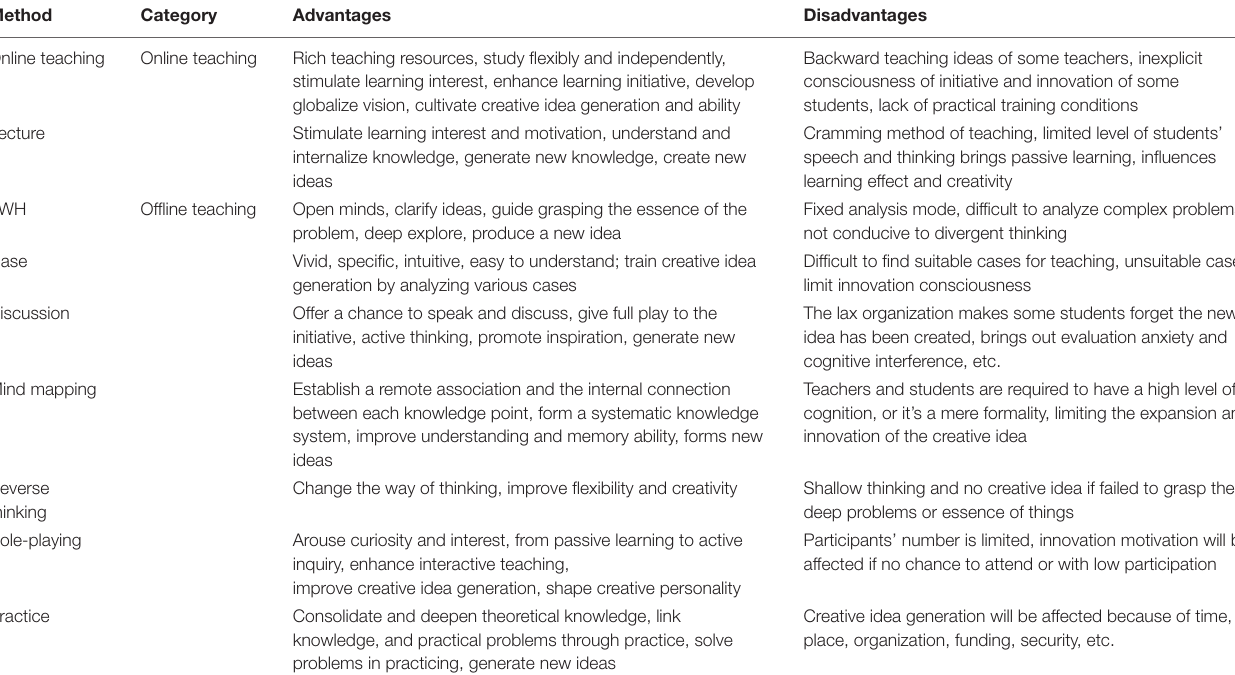
TABLE 1 | Advantages and disadvantages of online and offline teaching